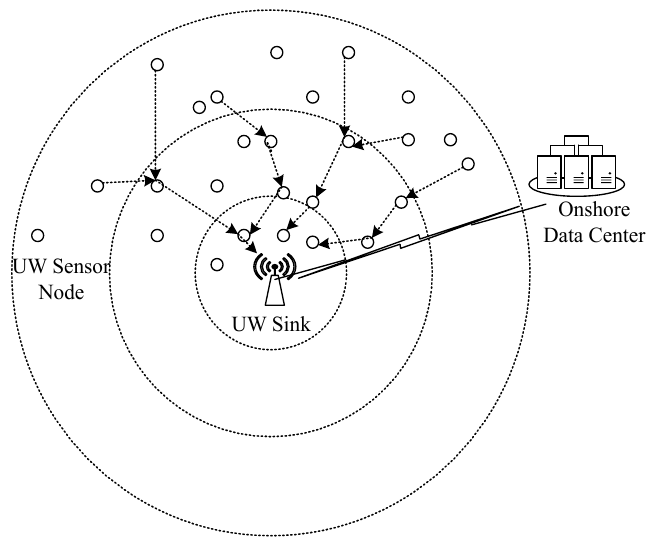
Figure 1. Underwater Acoustic Sensor Network (UASN)